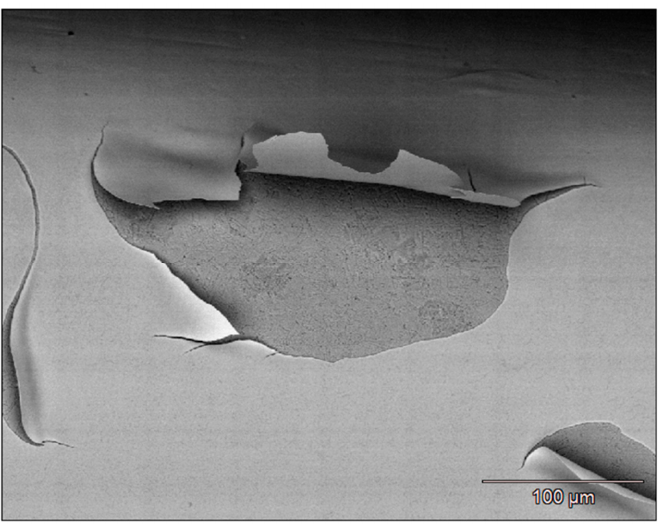
Figure 4. Exfoliation occurred on sample #12 observed by SEM in backscattered electrons mode.